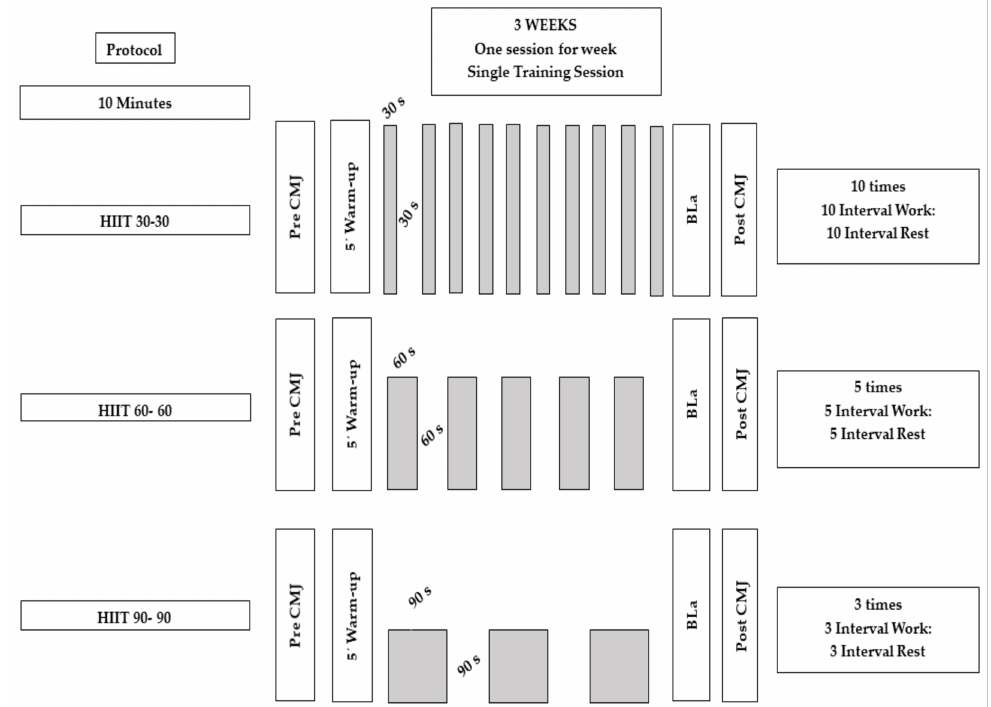
Figure 1. Scheme of the training sessions. BLa = Lactate; CMJ = Counter movement